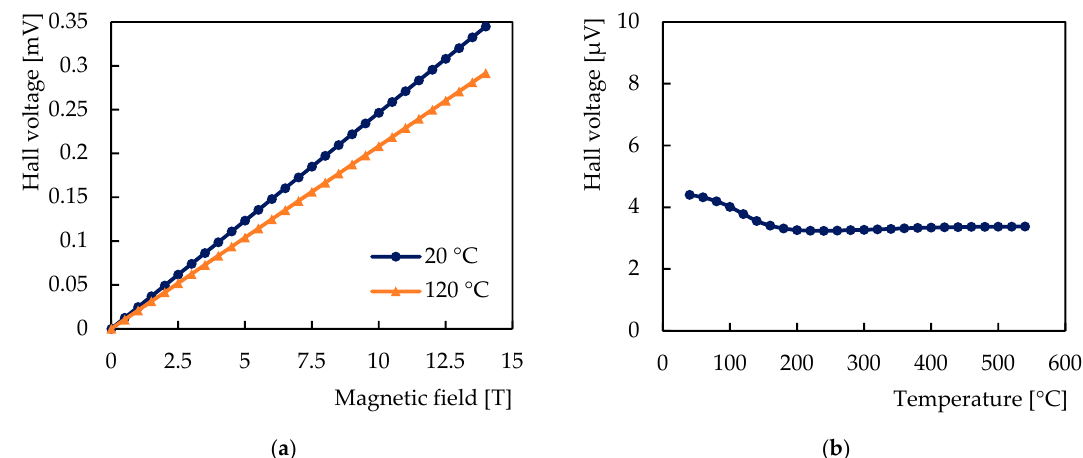
Figure 5. Hall voltage of the tested sensor with chromium sensitive nanolayer: ( a ) Dependence on the magnetic field at 20 °C and at 120 °C; ( b ) Dependence on the temperature in the magnetic field of 200 mT.